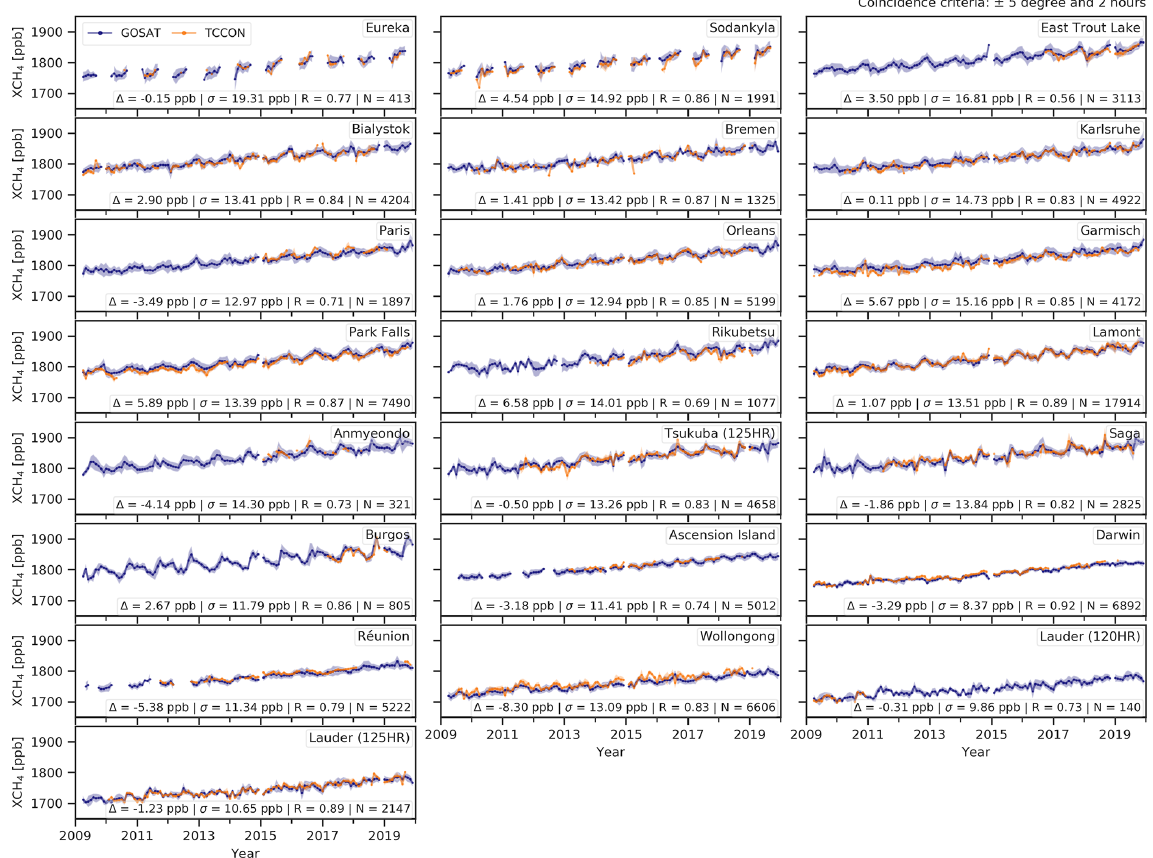
Figure 5. Time series plots for each TCCON site comparing GOSAT Proxy XCH 4 data to the matching co-located TCCON measure- ments. Statistics for each site are included, showing the average GOSAT–TCCON difference, the GOSAT–TCCON standard deviation, the correlation coefficients and the number of co-located GOSAT–TCCON measurements.